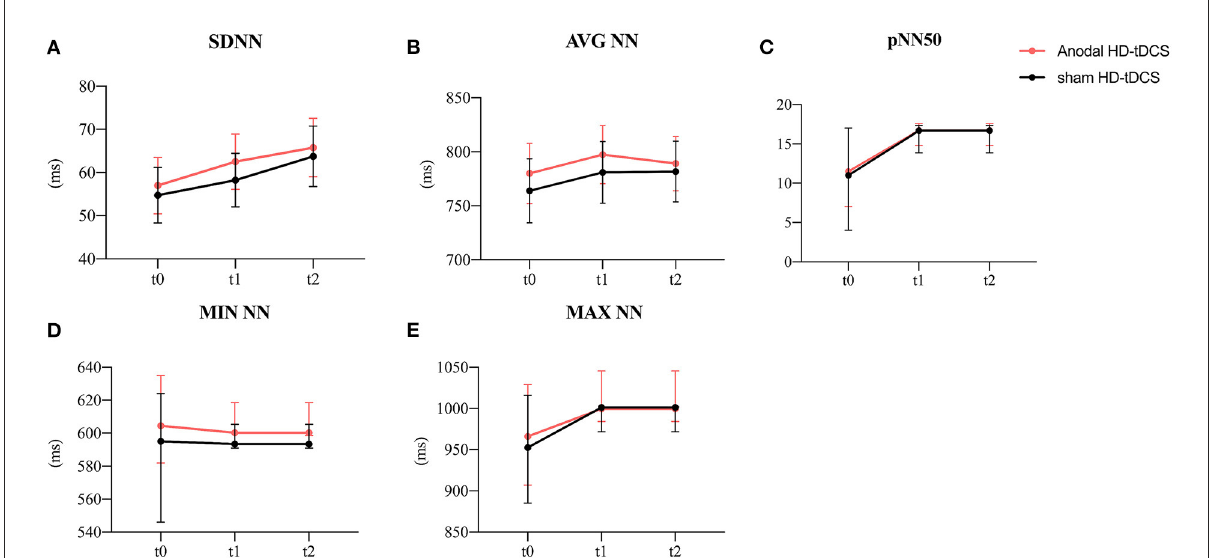
FIGURE4 Evolution of time-domain heart rate variability. (A) Effect of the intervention on SDNN. Graphs show the mean values with error bars indicating 95% confidence intervals. (B) Effect of the intervention on AVG NN. Graphs show the mean values with error bars indicating 95% confidence intervals. (C) Effect of the intervention on pNN50. Graphs show the median values with error bars indicating 95% confidence intervals. (D) Effect of the intervention on MIN NN. Graphs show the median values with error bars indicating 95% confidence intervals. (E) Effect of the intervention on MAX NN. Graphs show the median values with error bars indicating 95% confidence intervals. The red line represents the Anodal HD-tDCS group and the black line represents the sham stimulation group.